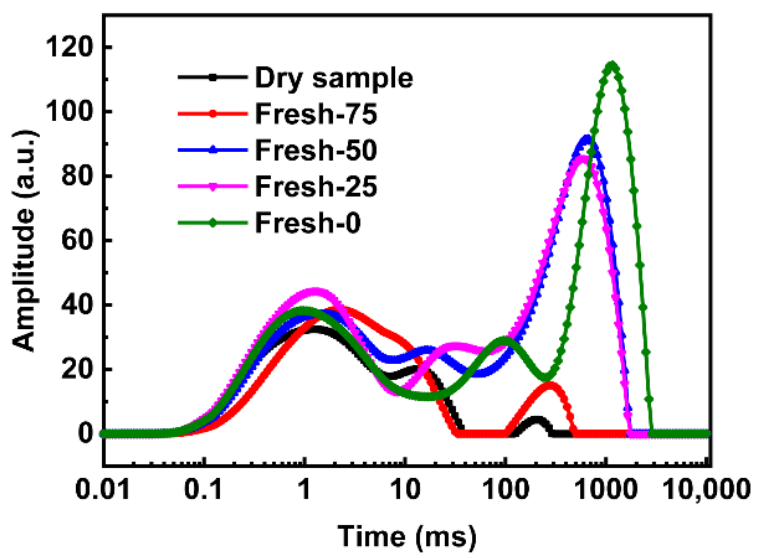
Figure 8. Relaxation time distributions for corncob pith in different conditions: (fresh-0) “as it was”; (fresh-25) after being dried at 40 °C for 25 min; (fresh-50) after being dried at 40 °C for 50 min; (fresh-75) after being dried at 40 °C for 75 min; (dry) after vacuum drying.